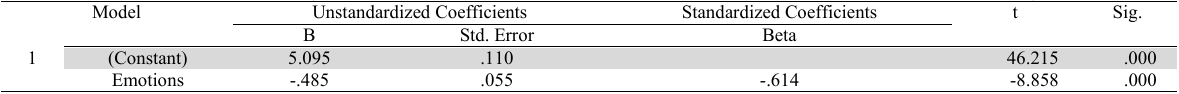
The summary of the results of regression analysis between lack of emotions and ethics-based decision making